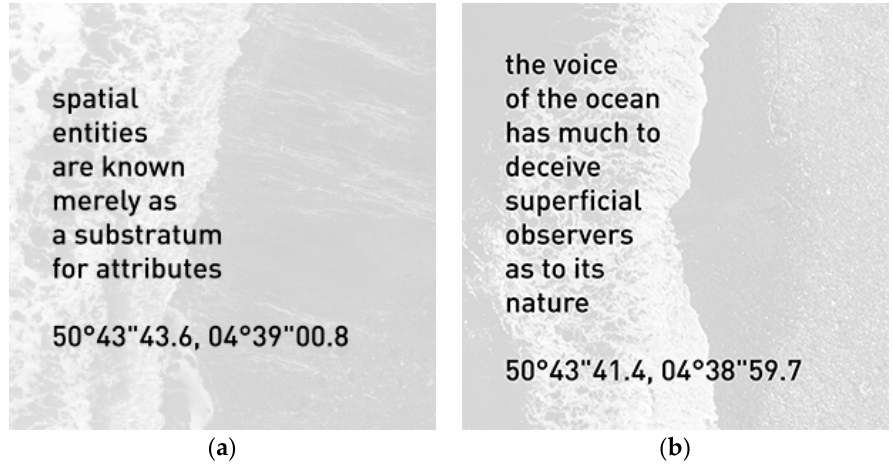
Figure 3. The final generated text. The source text for ( a ) was Alfred North Whitehead’s The Concept of Nature (1920), and for ( b ) R. M. Ballentyne’s The Ocean and is Wonders (1874). Source: Author.